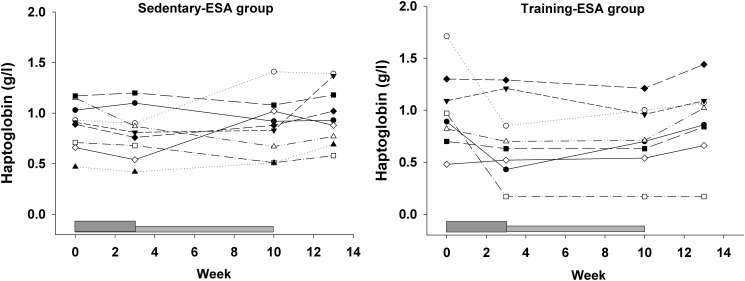
Total serum haptoglobin levels.The individual total serum haptoglobin levels in the sedentary-ESA and training-ESA groups, respectively, throughout the study period. The dark grey box at the bottom indicates the boosting period (first 3 weeks) and the light grey box the maintenance period (weeks 4–10), subjects were not treated during weeks 11–13 (wash-out phase).